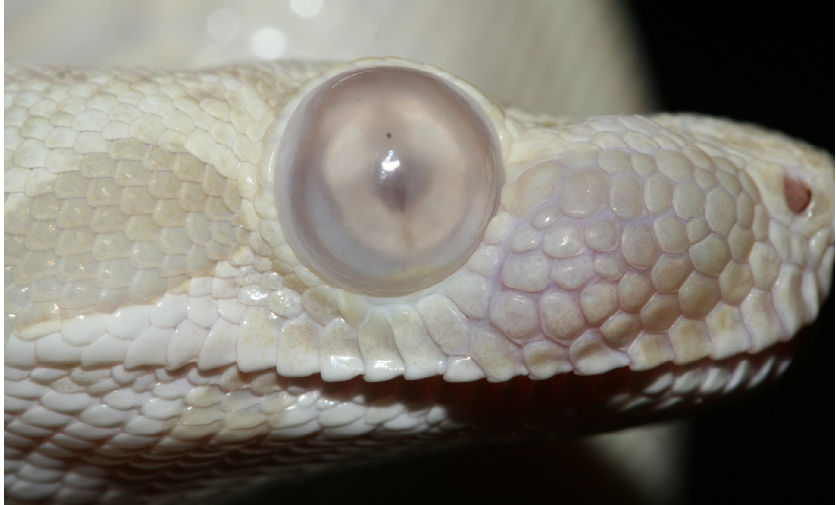
Figure 23. Pseudobupthalmos in a juvenile boa constrictor ( Boa constrictor ) combined with swelling of the facial region associated with ascending Pseudomonas aeruginosa infection via the lacrimal duct. If left untreated, subspectacular infection and abscessation might develop.